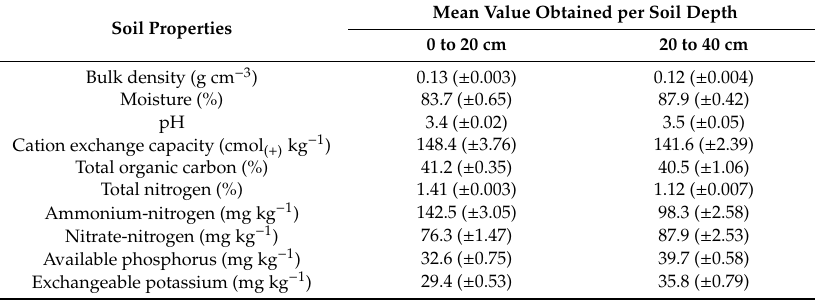
Selected physical and chemical properties of a peat soil at di ff erent depths at the Malaysian Agricultural Research and Development Institute (MARDI) Peat Research Station, Saratok, Sarawak, Malaysia. Soil